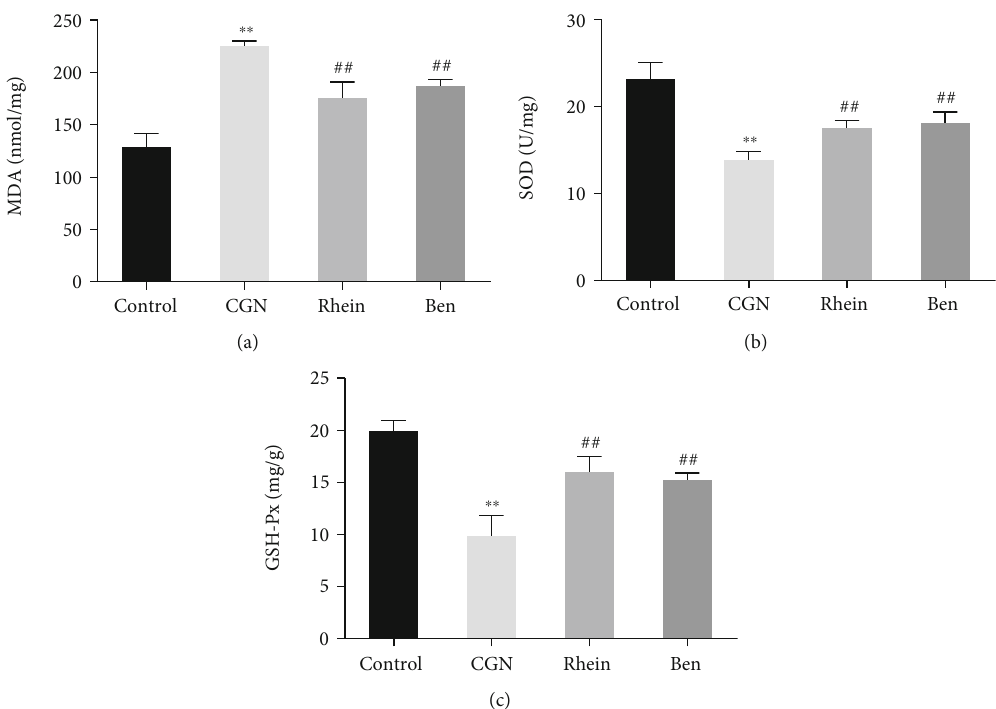
Figure 3: E ff ects of rhein on renal oxidant and antioxidant level in rats with chronic glomerulonephritis. (a – c) Biochemical detection was performed to check the level of MDA (a), SOD (b), and GSH-Px (c) in the kidney of rats in each group ( n = 6 ). ∗∗ p < 0 : 01 , control group; ## p < 0 : 01 , CGN